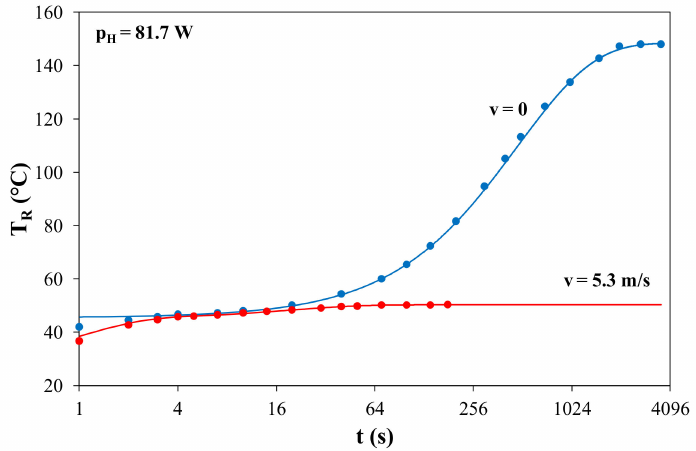
Figure 19. Measured and computed heating curves of the internal temperature of the resistor mounted on the heat sink with a silicon paste (system C) at selected values of the airflow speed.